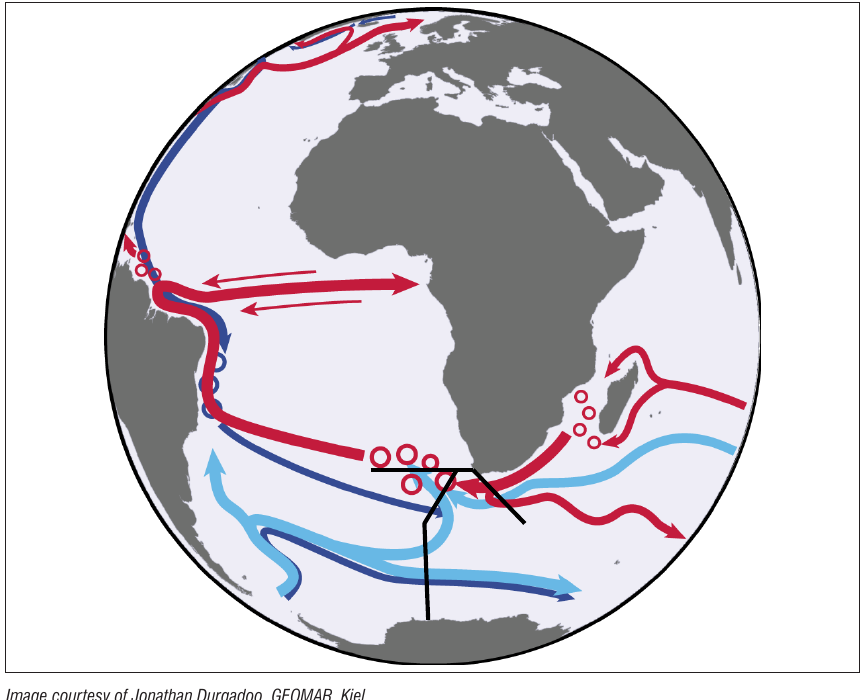
Image courtesy of Jonathan Durgadoo, GEOMAR, Kiel. Figure 1: Schematic of the ocean circulation south of Africa. Colours indicate surface (0–1000 m, red), inter- mediate (1000–1500 m, light blue) and deep (1500–4000 m, dark blue) pathways and their interconnectivity. In the South Atlantic, two northward flowing routes exist: the cold-water route which is the direct inflow from the Drake Passage, and the warm-water route southwest of South Africa. The three black lines highlight the main transects occupied by the SA Agulhas II during its annual relief voyages to the Prince Edward and Gough Islands and SANAE on the Antarctic continent. Measurement of the ionospheric dynamics by means of the ionospheric scintillation monitor on the SA Agulhas II provides a unique data set for studying the impact of the South Atlantic Magnetic Anomaly on ionospheric